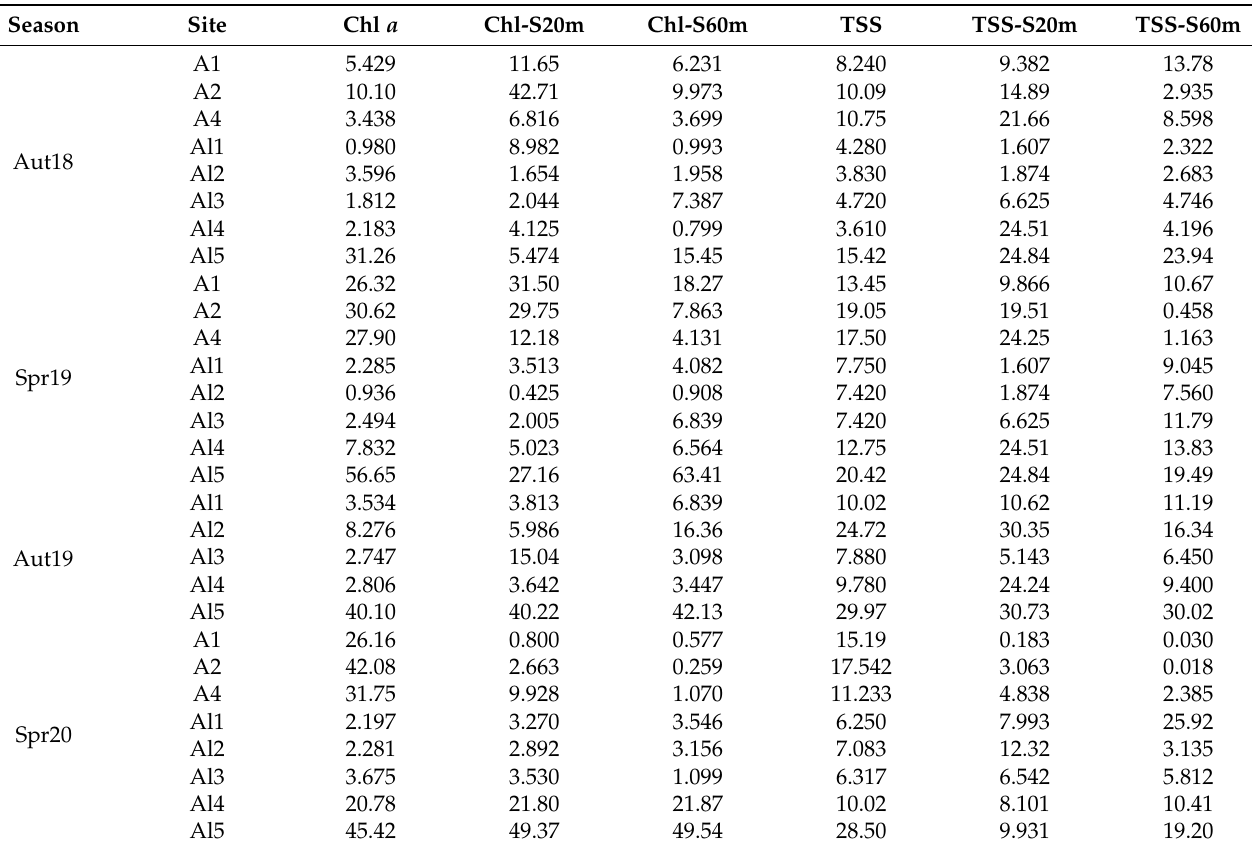
Table 2. Results from laboratory analysis and image processing using SNAP-C2RCC, concerning the Chl a and TSS parameters. “Chl a ” is the measurement in situ ( µ g L − 1 ) and “Chl-S20m” and “Chl-S60m” are the SNAP-C2RCC estimated variables for chlorophyll a ( µ g L − 1 ), using the 20 m and 60 m products, respectively. “TSS” is the measurement in situ (mg L − 1 ) and “TSS-S20m” and “TSS-S60m” are the SNAP-C2RCC estimated variables for total suspended solids (mg L − 1 ), using the 20 m and 60 m products, respectively. Sites A1 to A4 belong to the Aguieira reservoir and Al1 to Al5 to the Alqueva